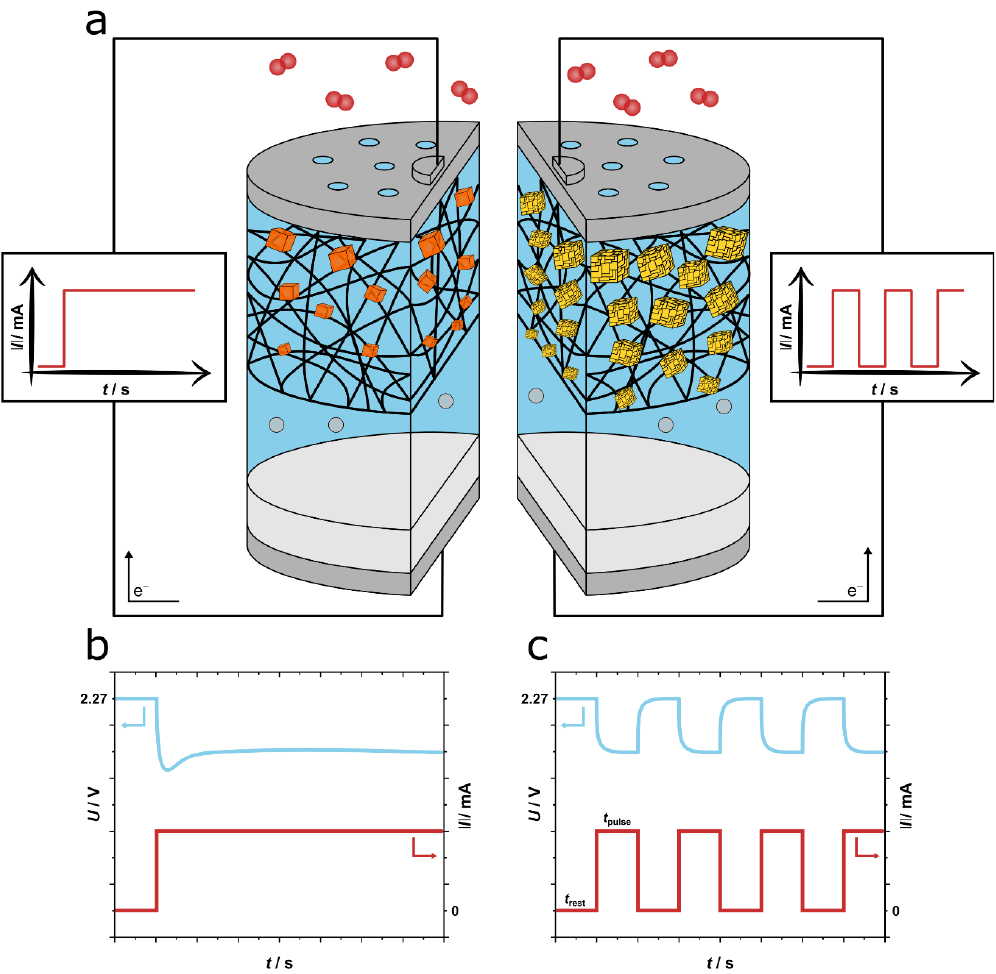
Figure 1. Illustration of the sodium-oxygen battery and discharging protocols considered in this work: ( a ) Schematic of the battery with discharge at constant current (left) and discharge at pulse current (right). ( b ) Qualitative description of the voltage response of a sodium-oxygen battery under constant current discharge and ( c ) under pulse discharging.